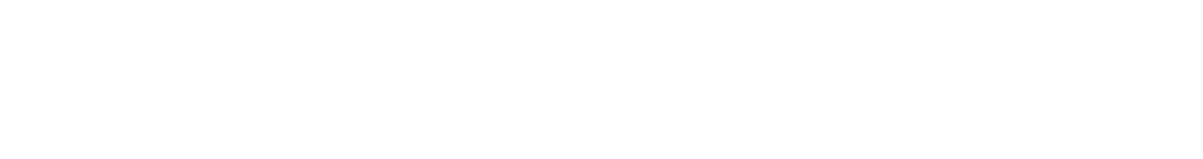
FIGUREA7 | Plot of curves of average diversity indices [(A): CHAO1, (B): Pielous’s evenness, and (C): Shannon] for soils spiked with phenanthrene (LP: phenanthrene-spiked Luvisol, CP: phenanthrene-spiked Cambisol) or